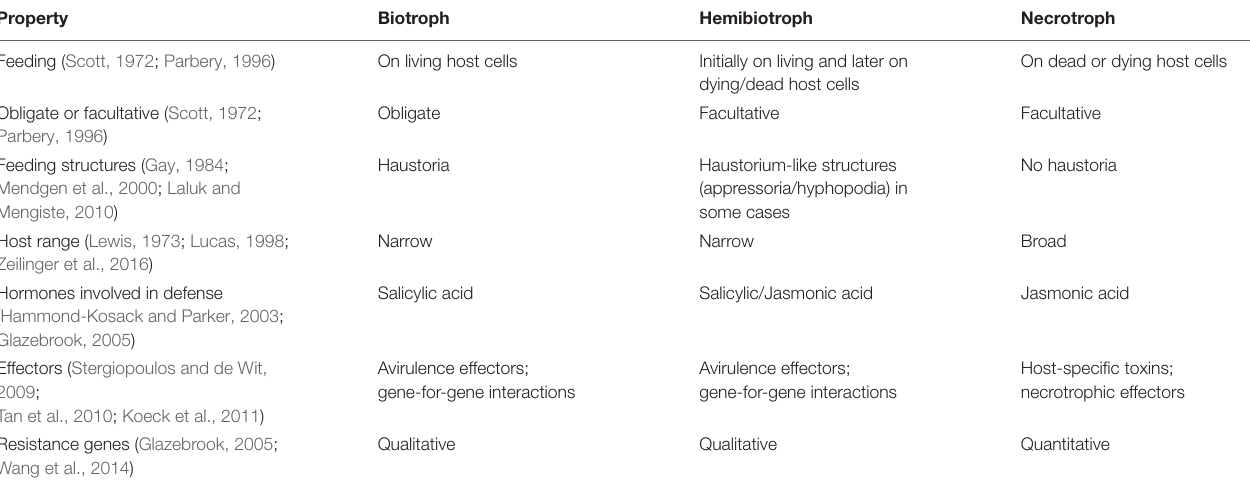
TABLE 1 | Alleged typical properties of pathogenic trophic